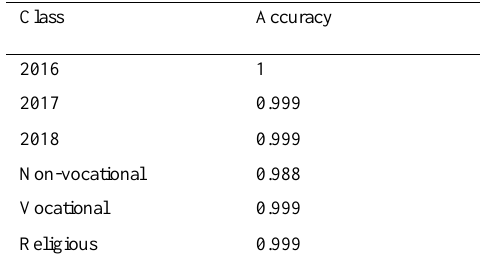
Table 2. Text model accuracy for each class on training